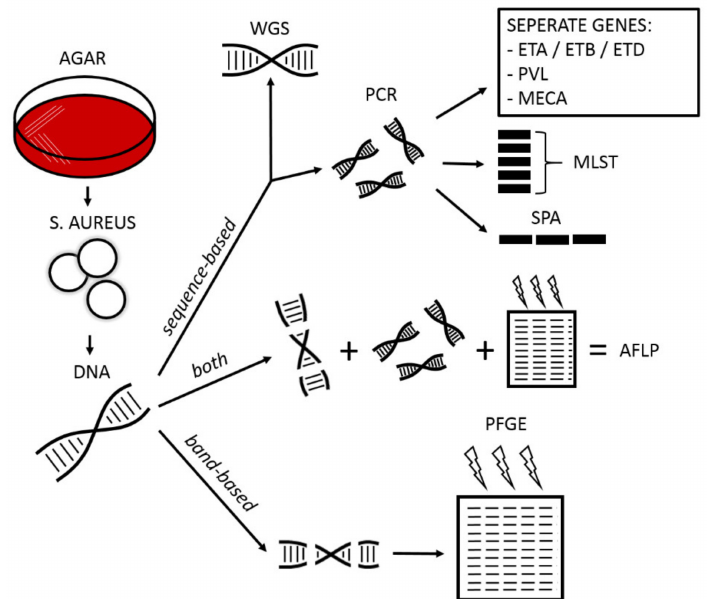
Figure 4. Typing of S. aureus . AFLP = amplified fragment length polymorphism; AGAR = agar plate; DNA = deoxyribonucleid acid; ETA/ETB/ETD = exfoliative toxin A/B/D; MECA= gene coding for methicillin resistance; MLST = multilocus sequence typing; PCR = polymerase chain; PFGE = pulsed-field gel electrophoresis; PVL = Panton Valentine Leukocidin; SPA = staphylococcal protein A; WGS = whole genome